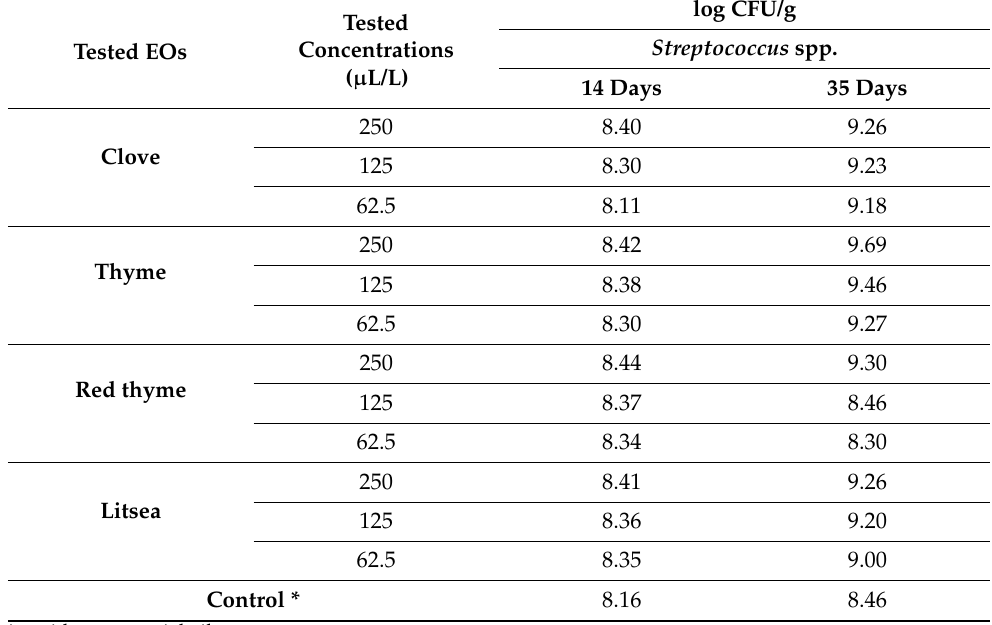
Table 6. The number of viable cells (log CFU/g) of the Streptococcus spp. in a model food (cheese) treated with essential oils on the 14th and 35th days of storage at a temperature of 5 ± 1 ◦ C.